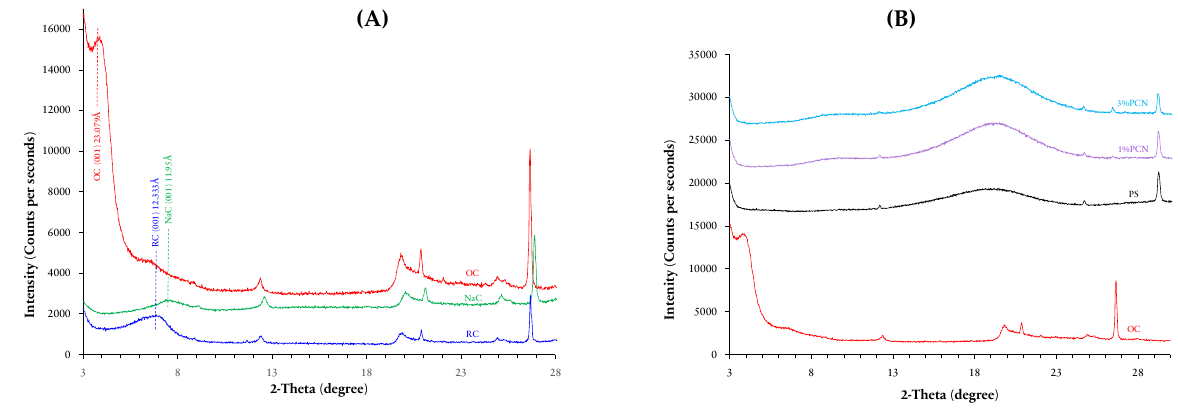
Figure 2. XRD images of ( A ) RC, NaC, OC, and ( B ) OC, PS, 1% PCN, 3% PCN.